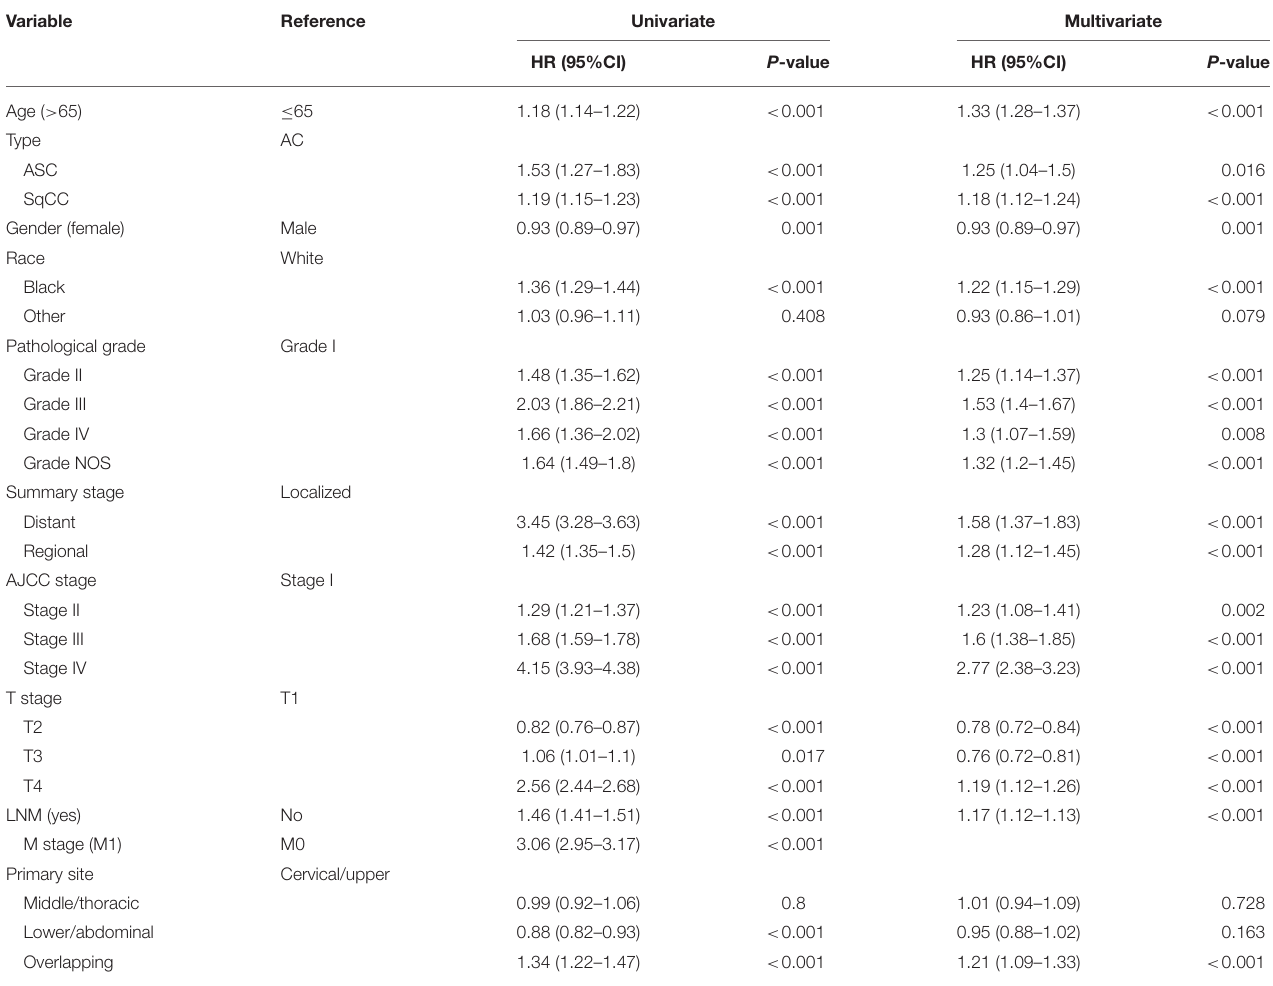
TABLE 2 | Univariate and multivariate cox analysis of clinical characteristics for the OS in all three esophageal cancer type patients.